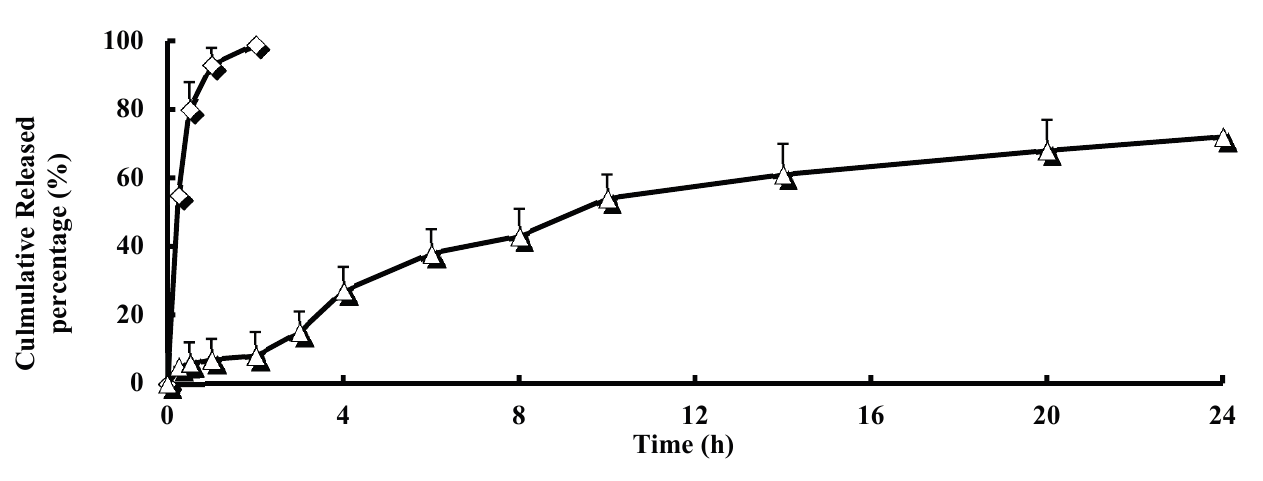
Figure 2. Drug release profiles of BUD microspheres ( △ ) and suspensions ( ◊ ) in simulated gastric fluid (SGF) (pH 1.2) for 2 h (Phase I), followed by simulated intestinal fluid (SIF) (pH 6.8) for the remaining time (Phase II) ( n =